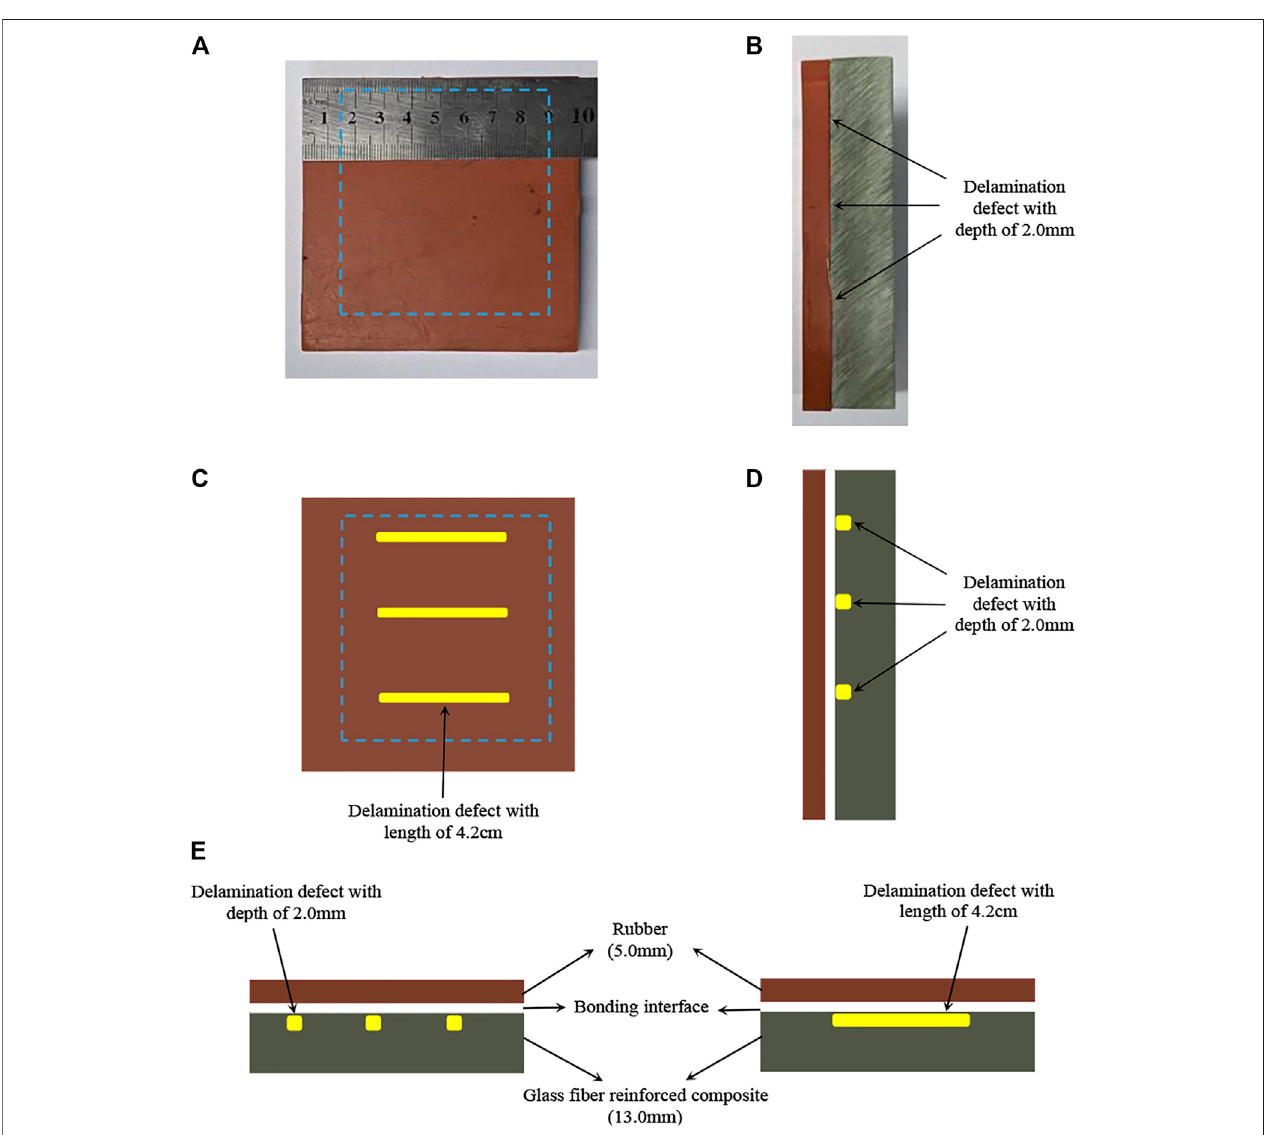
FIGURE4 | The actual photos, defect locationand size, structure diagram ofrubber and glass fi ber reinforced composite sandwich structure. (A) the actual photo (topview) , (B) theactualphoto(sideview), (C) thediagramofdefectlocationandsize (topview) , (D) thediagramofdefectlocationandsize(sideview), (E) thestructure